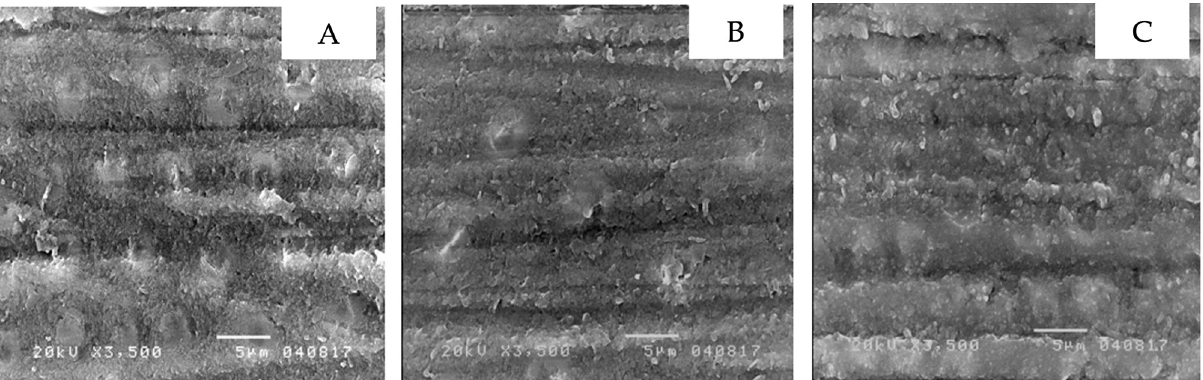
Figure 2. The dentin micro-morphology with a thick smear layer over the dentin surface: non-con- taminated dentin ( A ), dentin contaminated with topical anesthetic solution ( B ), dentin contami- nated with topical anesthetic gel ( C ).